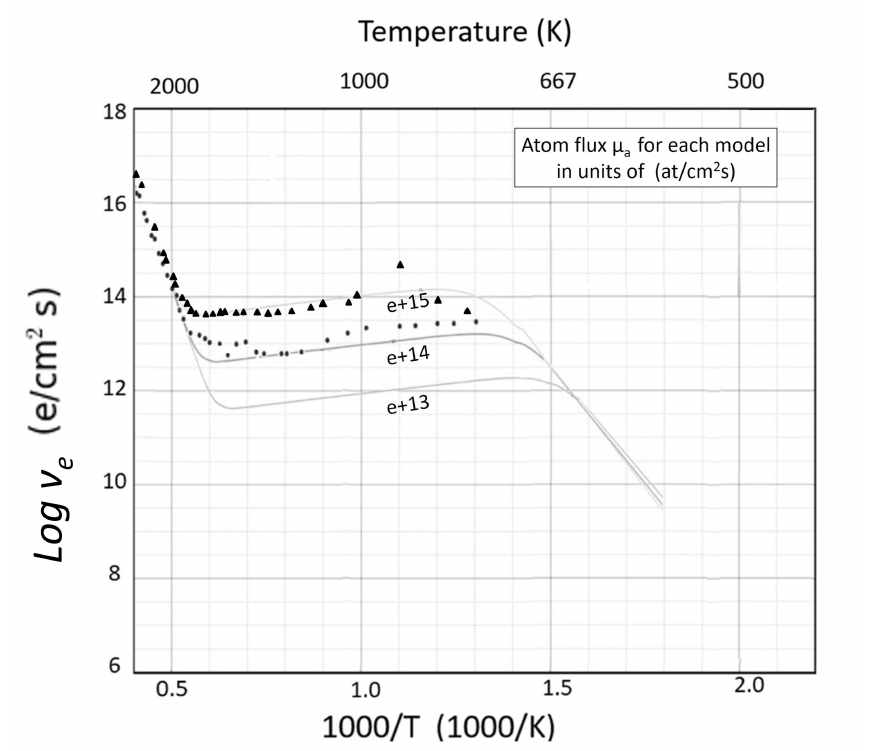
Figure 5. The logarithm of thermionic emission as measured by the gauge versus 1000/Filament Temperature for two measurements. Measurement A (triangles) was taken at a higher partial pressure of cesium than measurement B (circles), with the cesium source temperatures being 363 K and 305 K, respectively. The outlier in measurement A is most likely a mistake. Each curve is labeled with the atomic flux, where e+13 ≡ 1 × 10 13 (at/cm 2